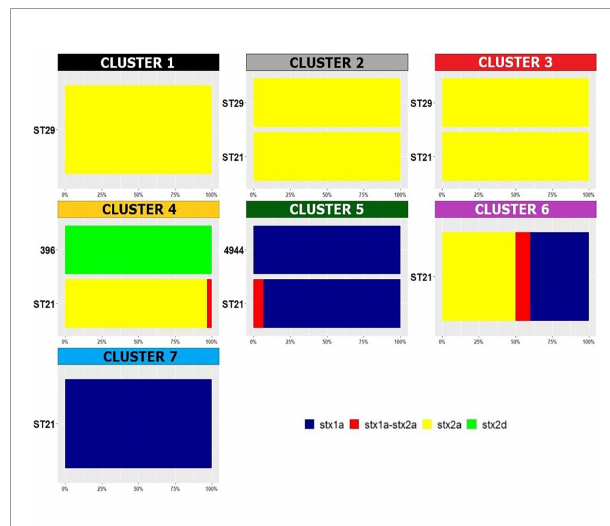
FIGURE 4 | Distribution of Sequence Types in the HCPC clusters. The percentage of the detected stx subtypes is reported within each cluster and per each ST. The legend for the colors indicating the stx subtypes is included in the fi gure.